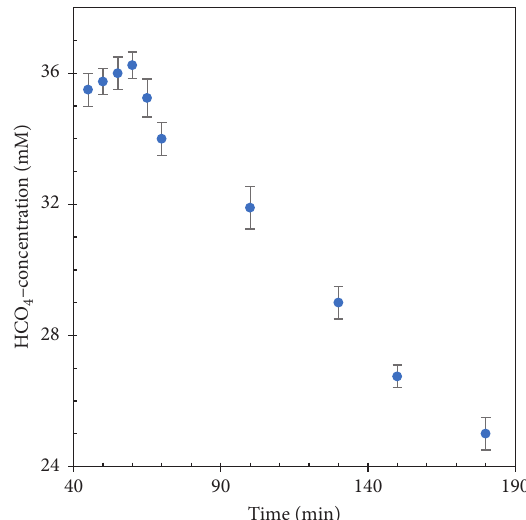
Figure 2: The variation of peroxymonocarbonate concentrations with time.